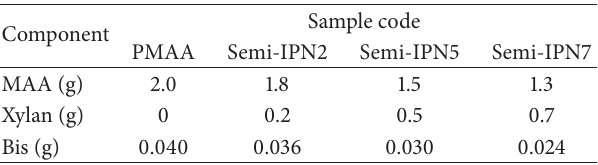
Table 1: Feed compositions for the preparation of xylan/PMAA semi-IPN